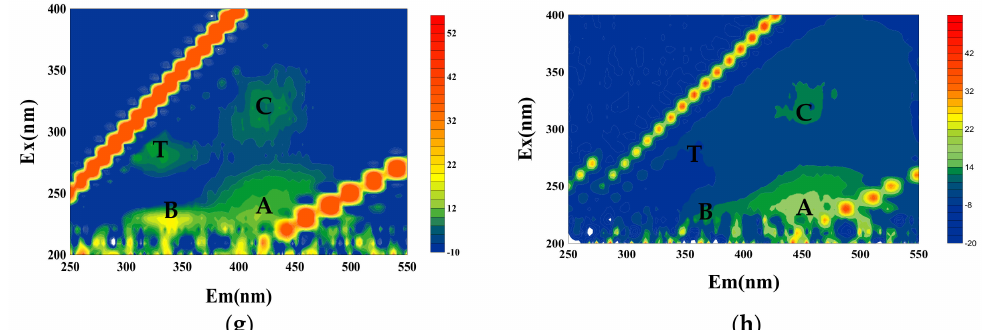
Figure 4. EEM spectra of the water sample of raw water, effluent, and mixing tank under different conditions: ( a ) raw water; ( b ) direct UF filtration, effluent; ( c ) L-UF, initial mixture; ( d ) L-UF, middle and later mixture; ( e ) L-UF, effluent; ( f ) S-UF, initial mixture; ( g ) S-UF, middle and later mixture; and ( h ) S-UF,